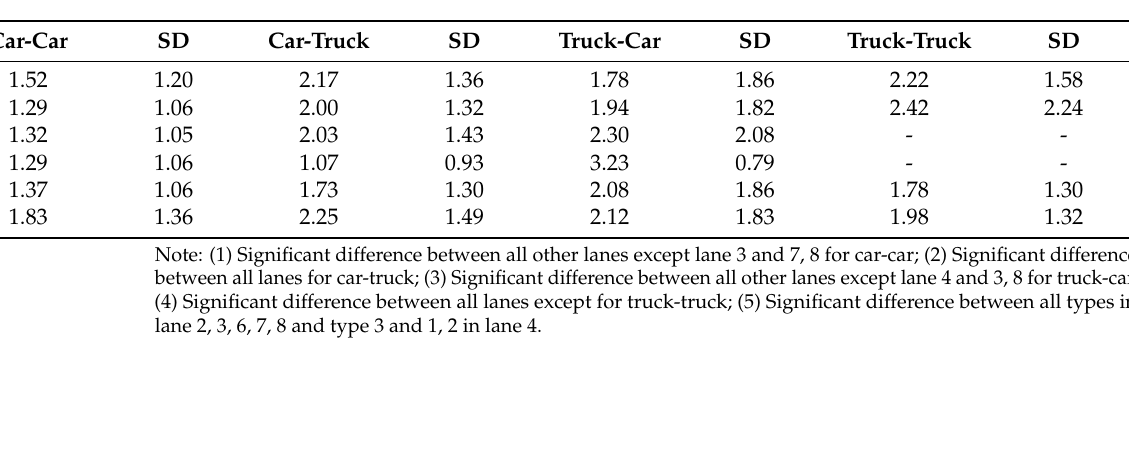
Table A7. The mean and standard deviation of THWmin when lane